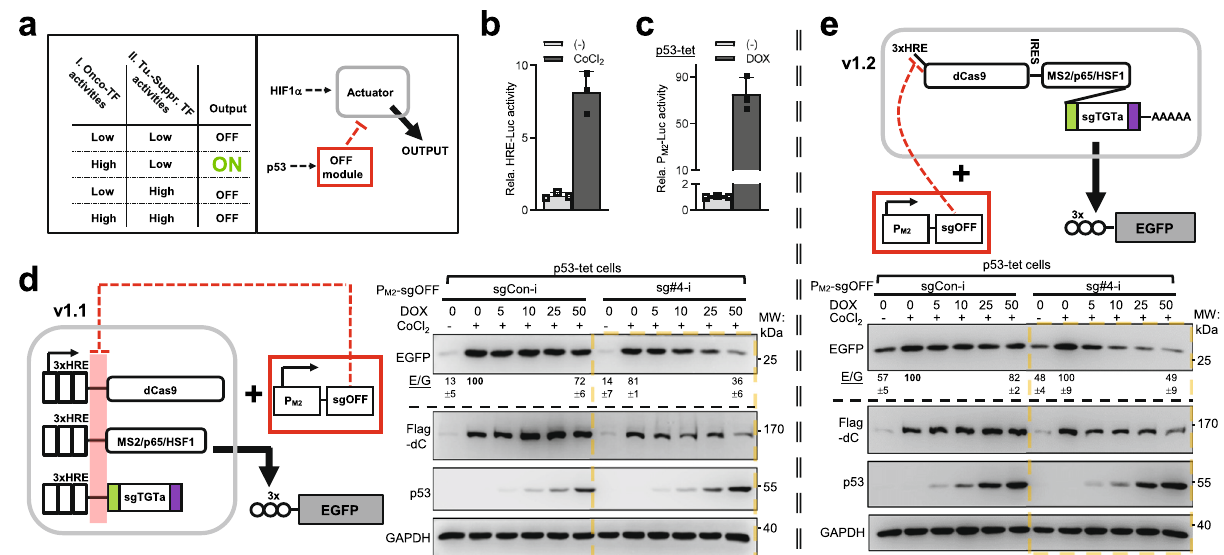
Fig. 3 Construction of a customized AND-NOT logic circuit (v1) targeting a malignant state. a The left box contains a two-input table based on activities of an onco-TF (I) and a tumor-suppressive TF (II) . The tumorous state can be gated by the status of this TFs using an AND – NOT logic ( “ ON ” in green). The right box illustrates the strategy for an AND – NOT logic, tumor-targeting circuit based on the activities of HIF1 α and p53. An output is engaged only in cells featuring high HIF1 α activity in conjunction with p53 de fi ciency. b H1299 cells were transfected with a 3× HRE-luciferase reporter and treated with 150 μ M CoCl 2 for 24 h. Relative levels of luciferase activities were presented (mean ± SD, n = 3 biological replicates). c H1299 cells were introduced with tetracycline-inducible p53 via a lentiviral vector ( “ p53-tet ” ). These cells were transfected with a p53-responsive P M2 -luciferase construct and treated with 50 ng/ml of DOX for 48 h. The cells were harvested for luciferase assay (mean ± SD, n = 3 biological replicates). d The illustration on the left shows the design for an AND – NOT circuit ( “ v1.1 ” ). Each CRISPRa component (to activate EGFP transcription) is controlled individually by a 3× HRE promoter, whereas the sgOFF is driven by a p53-responsive promoter (P M2 ). In the results shown on the right, the effects of P M2 -sg#4-i were compared to sg-Con-i in p53-tet H1299 cells. The circuit-introduced cells were treated with ±150 μ M CoCl 2 and ±DOX (with indicated doses) for 24 h. Cell lysates were examined by IB. The dCas9 levels were represented by their Flag tag (Flag-dC). e All CRISPRa components were assembled into one single 3× HRE- controlled unit, as shown in the illustration on the top. Other designs and experiments were similar to those in ( d ). According to its stage of development, the circuit is named “ v1.2 ” . In d , e , the blotting results are representative of two independent experiments. In addition, quantitation for the basal, CoCl 2 , and co-addition (DOX at 50 ng/ml) groups pooled from four independent experiments are marked below the corresponding EGFP panel (E/G, EGFP normalized to GAPDH, mean ± SEM). Source data are provided in the Source Data fi